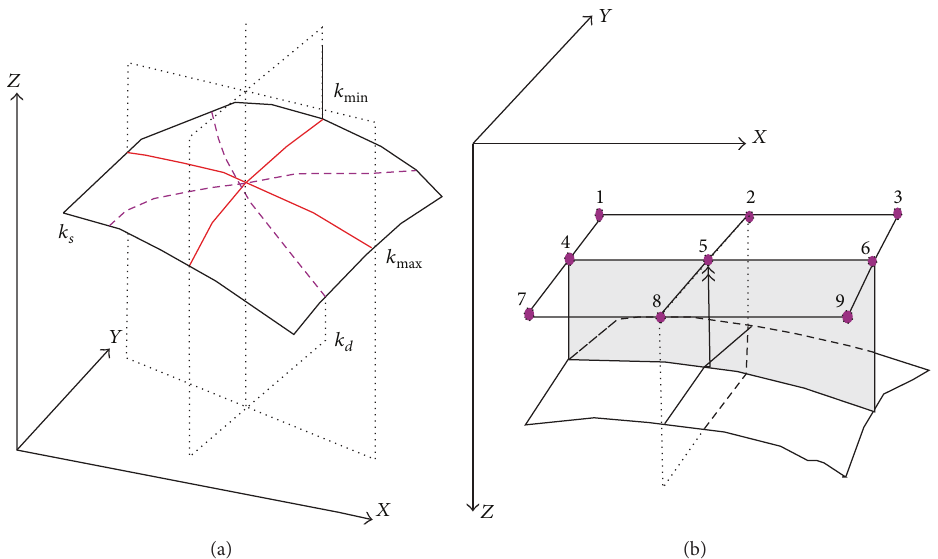
Figure 3: Sketch map and algorithm of 3D curvature [7].